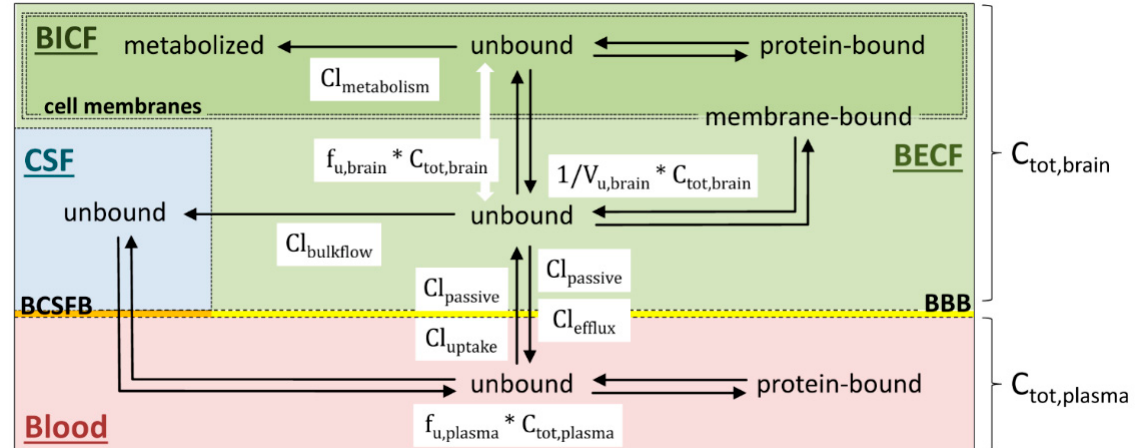
Figure 3. Overview of the equilibria involved in CNS penetration by drugs and their intra-brain distribution. The total concentration of a drug in plasma ( C tot,plasma ) is the sum of protein-bound and unbound drug species, of which only the unbound fraction ( f u,plasma ) can penetrate the blood brain barrier (BBB) or blood cerebrospinal fluid barrier (BCSFB), respectively. Drug transfer from blood to brain extracellular fluid (BECF) is usually driven by diffusional clearance ( Cl passive ) and active uptake transporter clearance ( Cl uptake ) of the drug across the BBB. Once it has entered the brain, the unbound drug (middle) may bind to its target (if the target is extracellular), and/or nonspecifically bind to brain tissue (middle right) and/or be cleared from BECF through various pathways. In particular, the unbound drug may be removed back to plasma through diffusional clearance ( Cl passive ) and/or active efflux ( Cl efflux ) across the BBB (bottom), it may be cleared due to bulk flow of BECF ( Cl bulkflow ) into CSF (left), and/or it may enter the brain intracellular fluid (BICF) due to uptake into cells (top). Likewise, within BICF, the unbound drug (top middle) may bind to its target (if the target is intracellular), and/or it may become bound to intracellular proteins (top right), and/or it may be cleared by metabolic enzymes ( Cl metabolism ) in the cells (top left). Note that drug metabolism may also take place at the BBB or in BECF, which has been omitted for clarity. Because the unbound drug fraction ( f u,brain ) is determined in homogenized tissue, it lumps together the unbound drug fractions in BECF and BICF. In contrast, the unbound volume of drug distribution ( V u,brain ) is determined by in vivo microdialysis or in brain slices, so that it provides a measure for the unbound drug fraction in BECF.